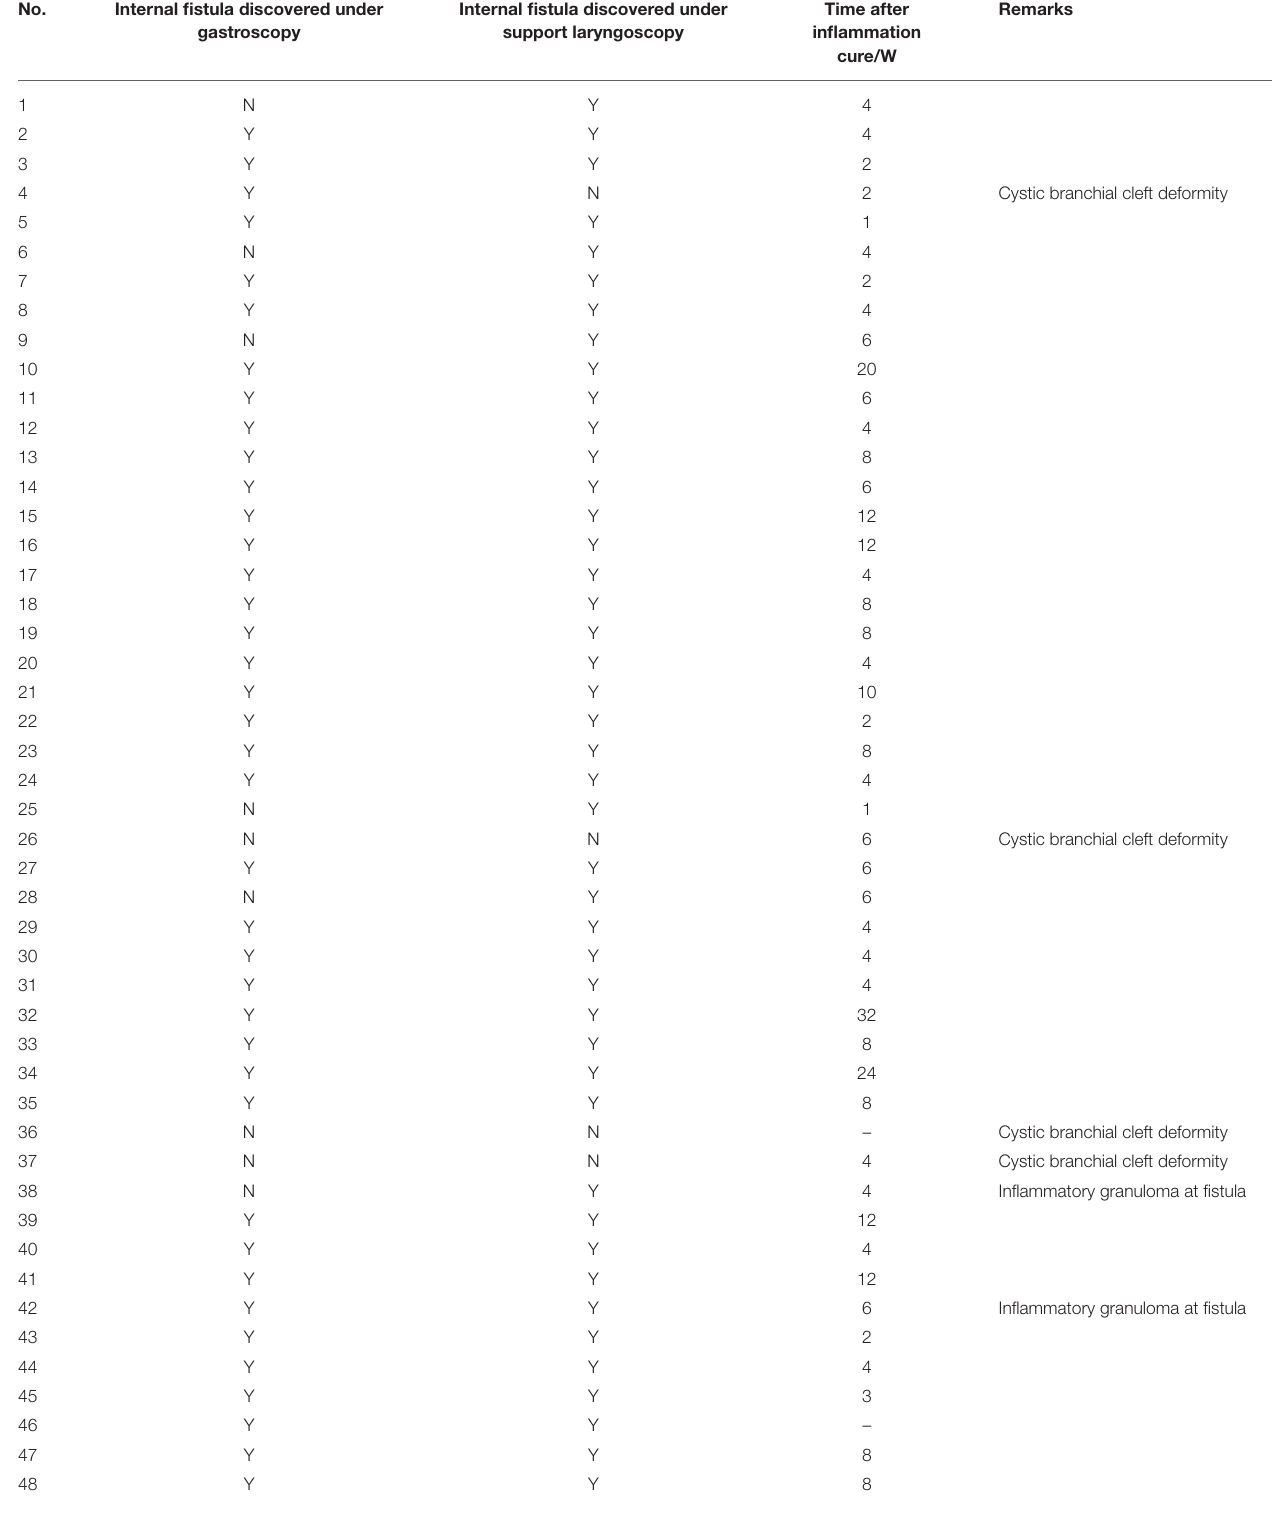
TABLE 2 | Exploration results of the internal opening of CPSF by gastroscopy under local anesthesia and support laryngoscopy under general anesthesia.